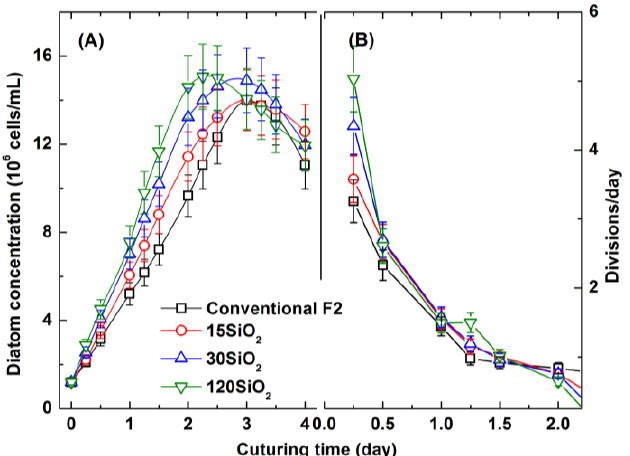
Fig. 7. The increase of the Chaetoceros sp. concentration during cultivation (A) and the change of division rate (B) in different solid-silica concentrations in comparison with conventional F2 culturing